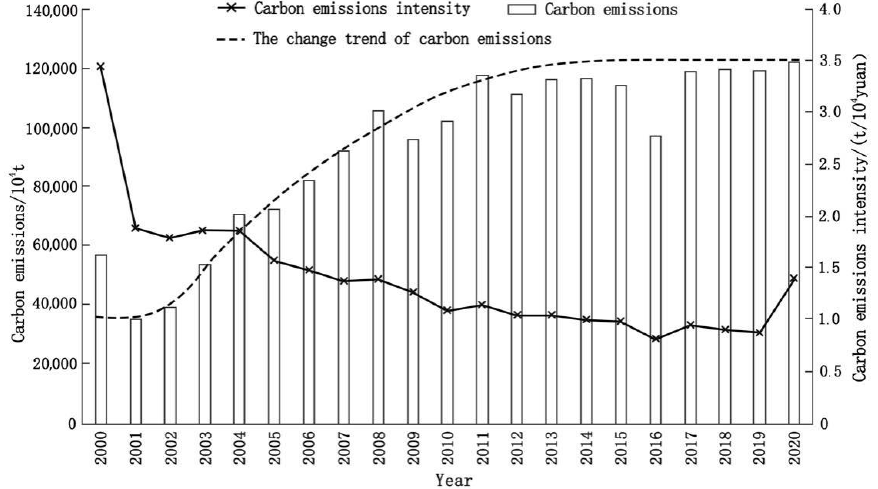
Figure 3. Status of energy carbon emissions in the YRD from 2000 to 2020.